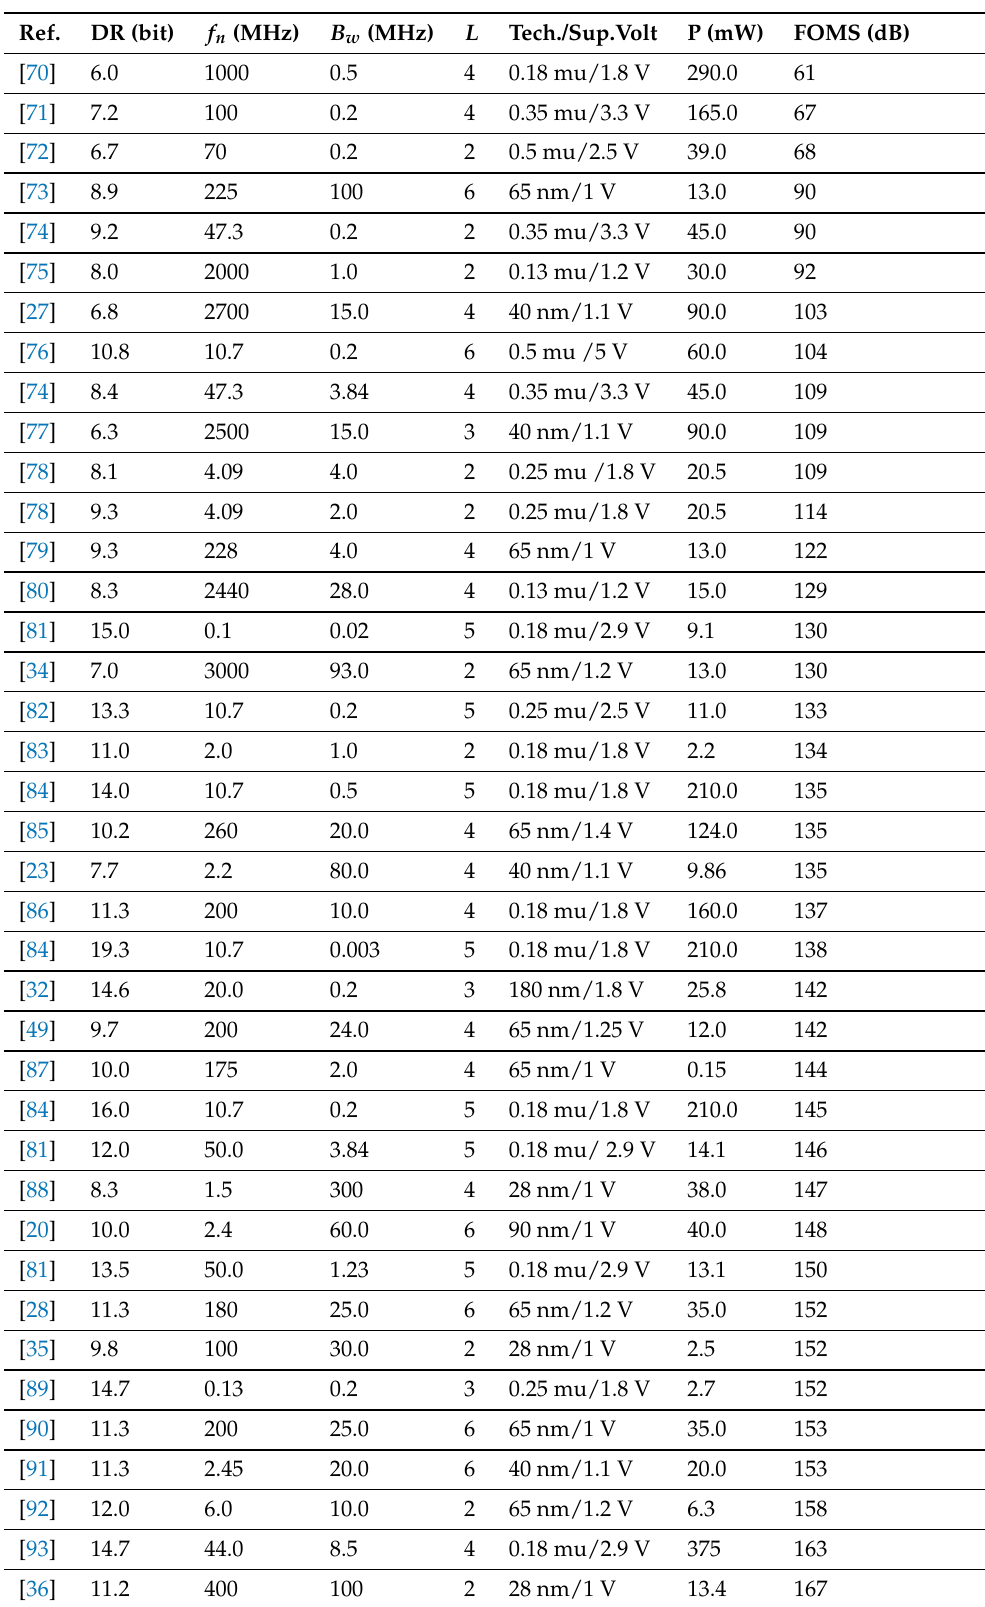
Table 2. Summary of the state of the art on CT BP- Σ∆ Ms (sorted by FOMS).